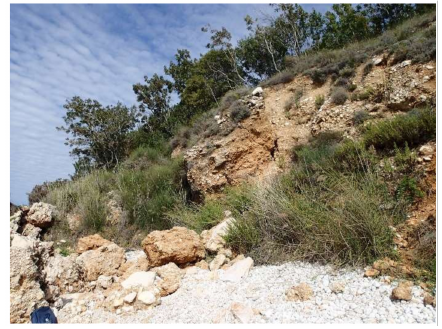
Figure 6. Cliff formed in talus